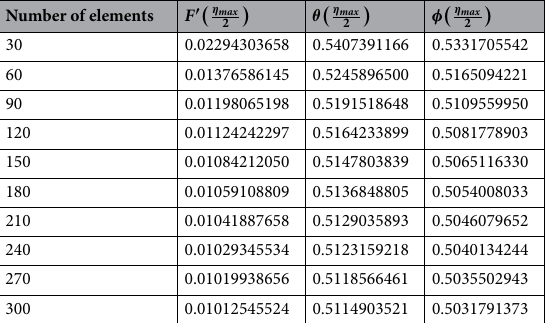
Table 2. Numerical study of mesh-free for concentration, velocity and heat energy profiles via mid of 300 elements when α = 0.5, m = 0.3, Re = 4.0, we = 3.0, M = 3.0, Pr = 206, H t = − 2.0, Sc = 0.0, δ 1 = 0.4,